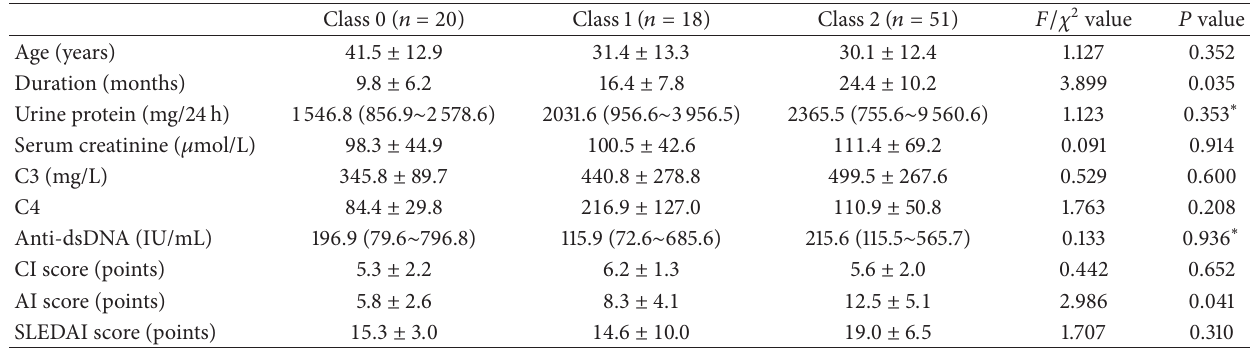
Table 2: The clinical data of patients with different ELT classes of renal tissues.